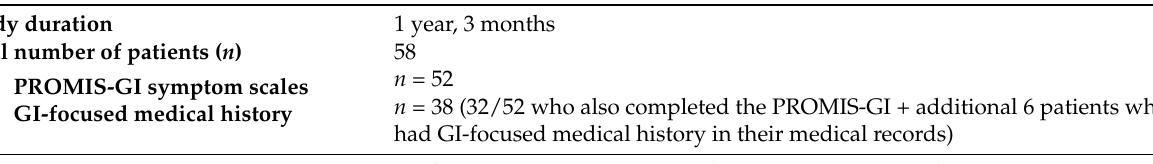
Table 1. Patient demographics for the GI study in adult patients with LOPD.